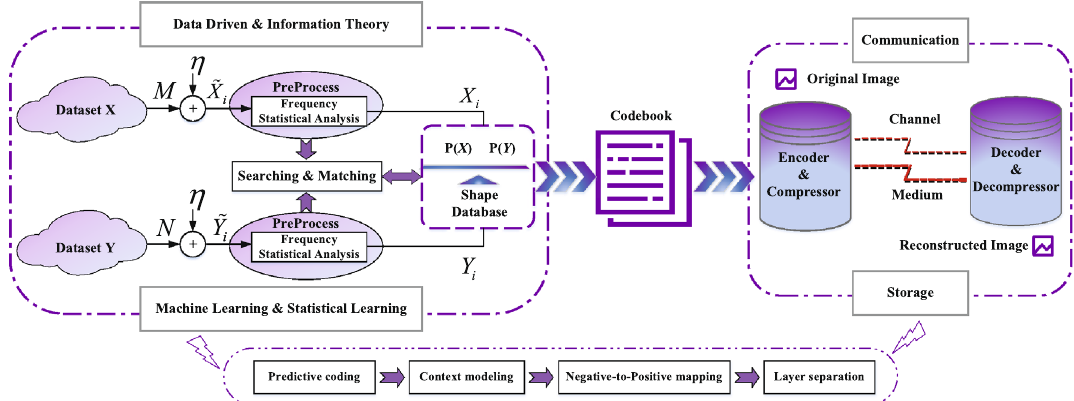
Figure 2. The structure of soft compression algorithm. It consists of the generation and use of the codebook. The former takes advantage of the characteristics of the data source, while the latter improves the compression performance.